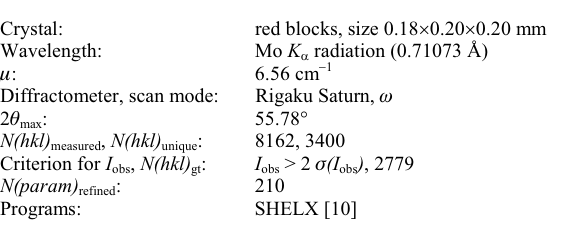
Table 1. Data collection and handling.